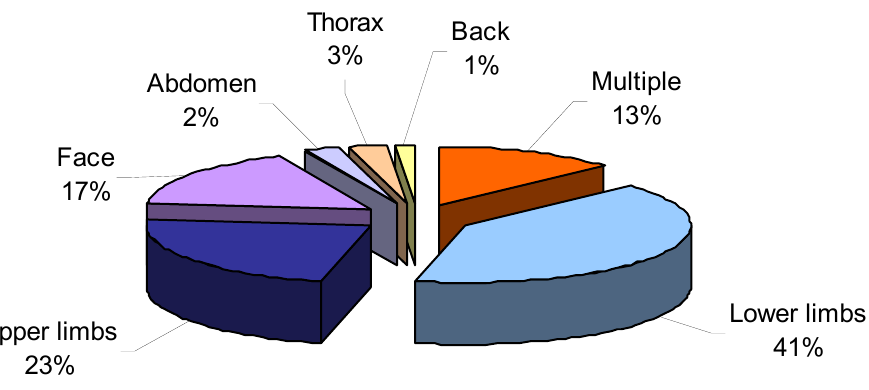
Figure 6. Parts of the body affected by jellyfish stings.